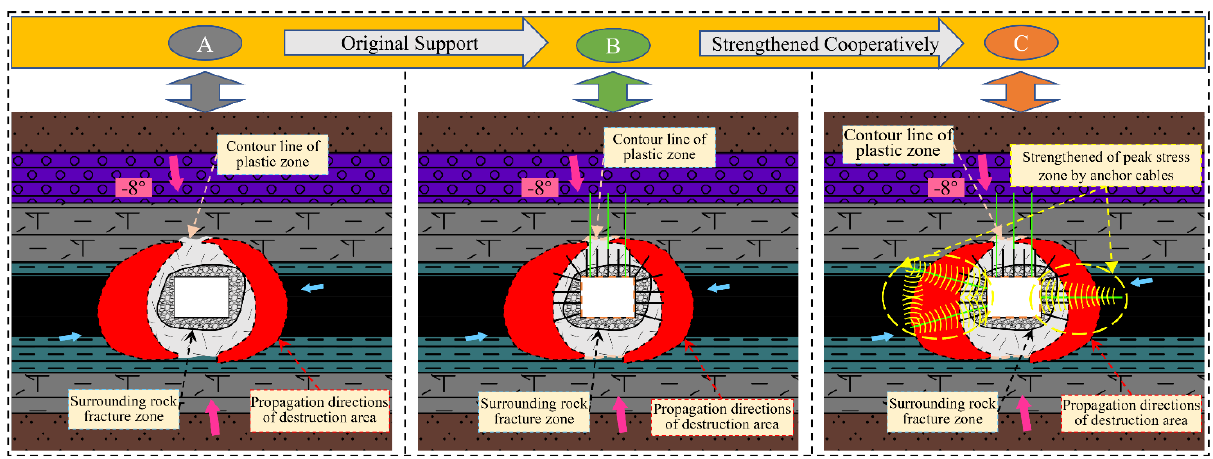
Figure 16. No.3 coal seam main return-air roadway support stress field.